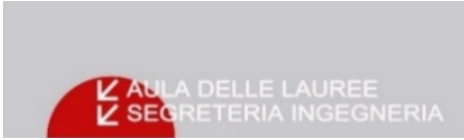
Figure 9. Signposting at nodes.